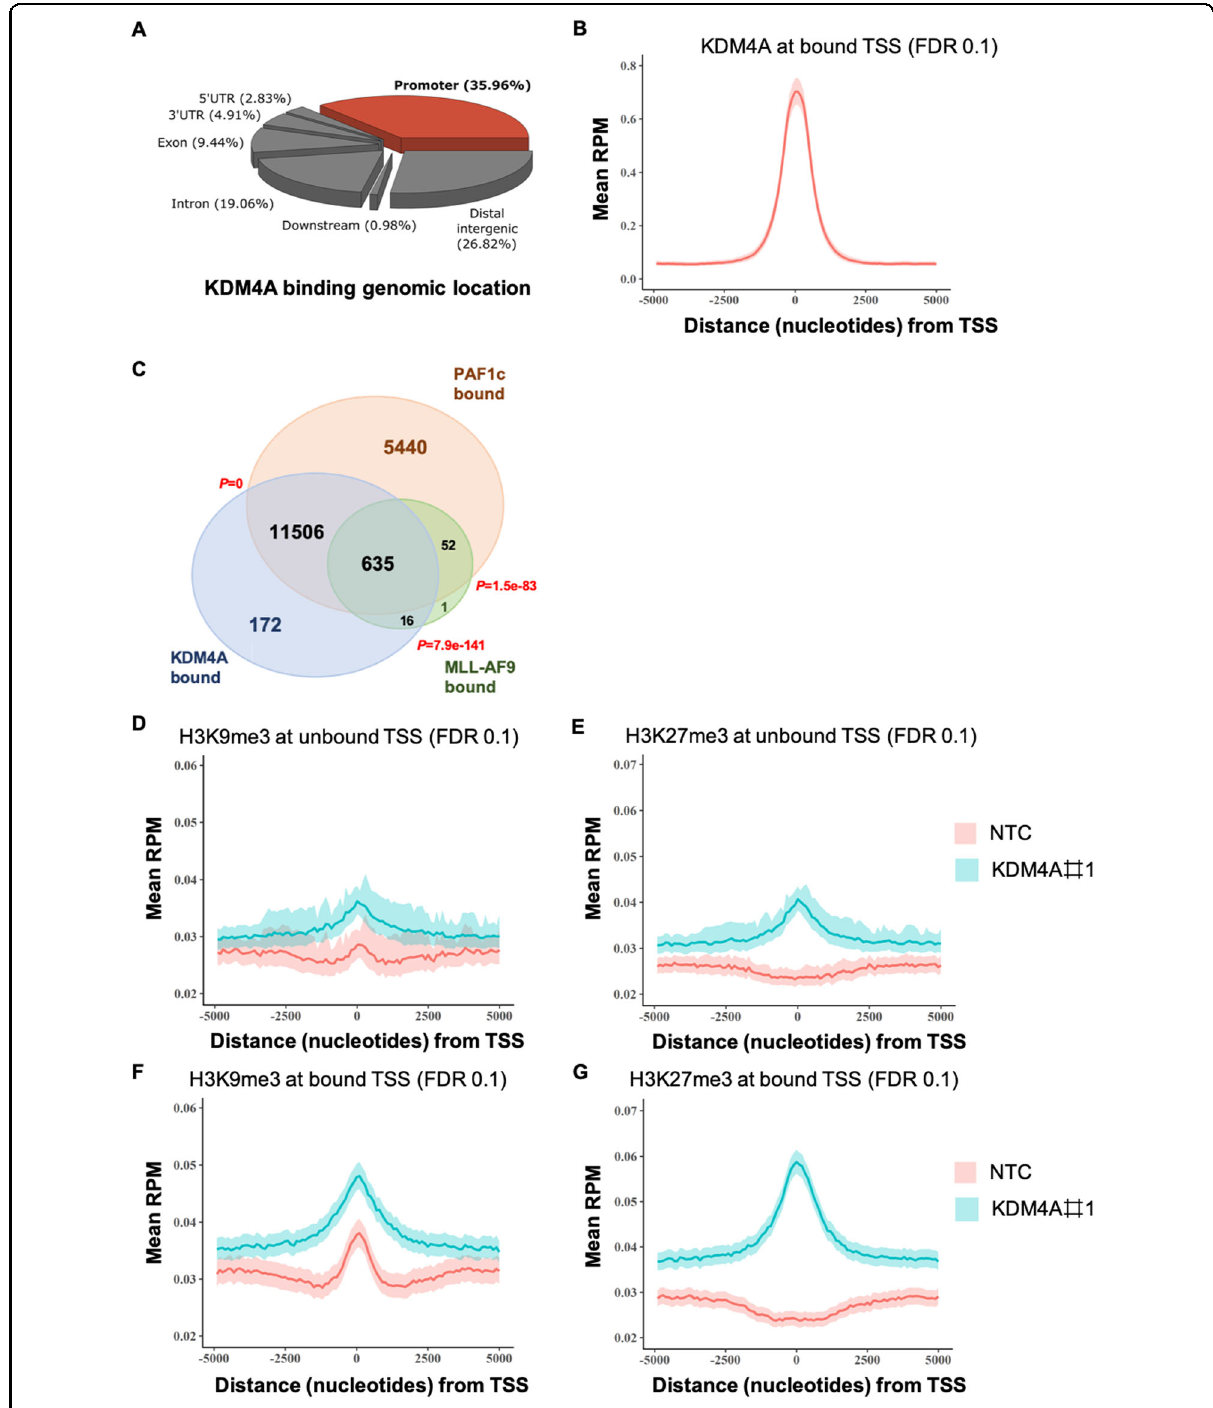
Fig. 4 KDM4A-PAF1 co-regulates essential MLLr-fusion oncogenic transcriptional program. A Feature distribution of KDM4A ChIP-seq peaks in the THP1 cell genome. B Metagene plots showing a distinct peak in KDM4A normalized ChIP-seq signal in reads per million mapped reads (RPM) at transcription starting sites (TSS) in WT THP1 cells. C Venn diagram showing the overlap between binding sites of KDM4A, PAF1c 26 , and MLL-AF9 29 in THP1 cells as determined by ChIP-seq; p by hypergeometric test. D – G Metagene plots showing enrichment of H3K9me3 ( F ) and H3K27me3 ( G ) at KDM4A bound TSS compared to unbound TSS ( D and E ) following KDM4A KD by